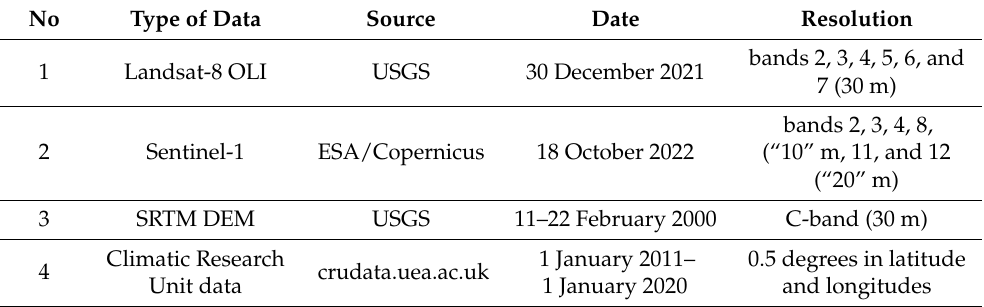
Table 1. Data used in present